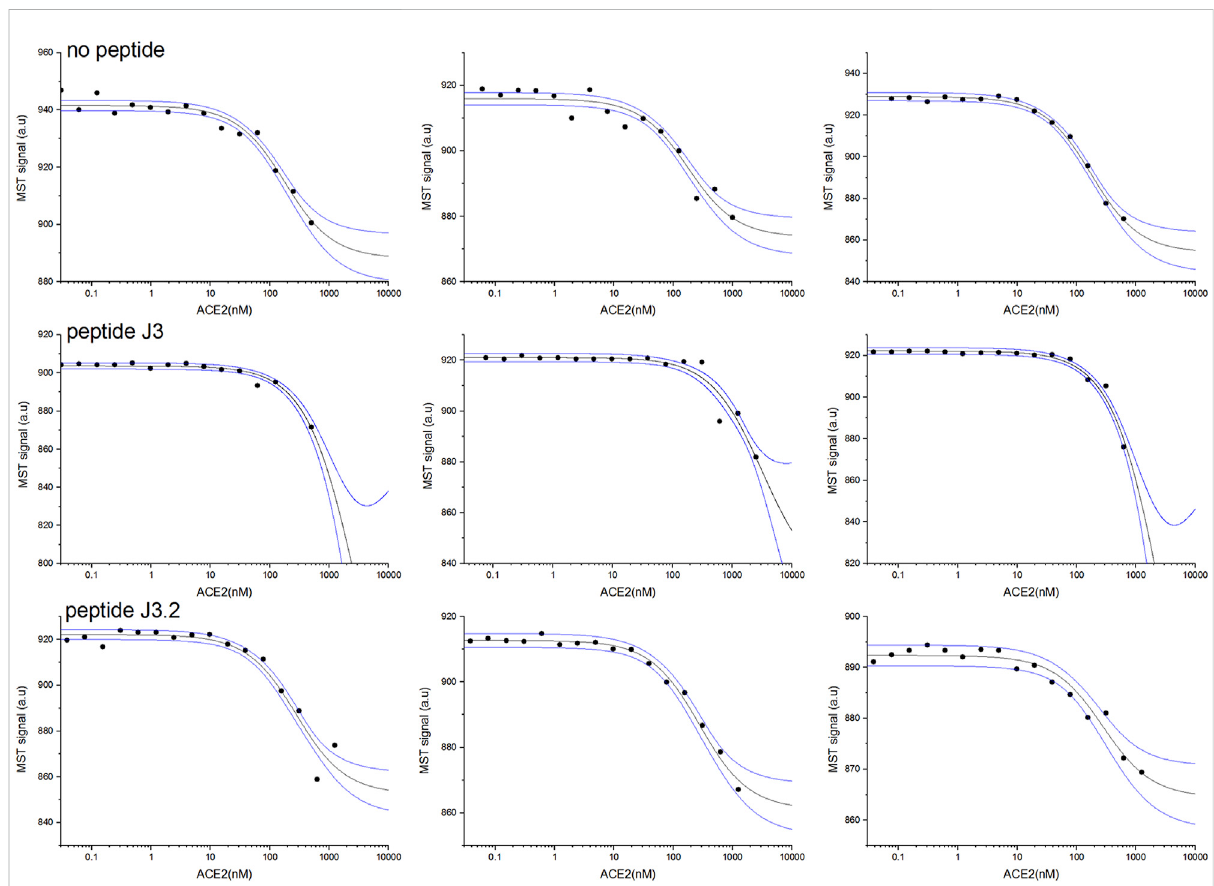
FIGURE 3 RBD and h ACE2 interaction inhibition assay for best peptides binders J3 and J3.2 monitored by MST pseudo-titration experiments. Two components experiment without peptides (upper panel). Three component experiment repeated in the presence of peptide J3 (middle panel) and peptide J3.2 (lower panel) at a constant concentration of 1 mM. The concentration of h ACE2 (unlabeled) varied from 30 pM to maximum 2.5 µM, whereas RBD (His-Tagged) was kept constant at50 nM. Black lines represent the model fi ttedfor each peptide globally using data from at